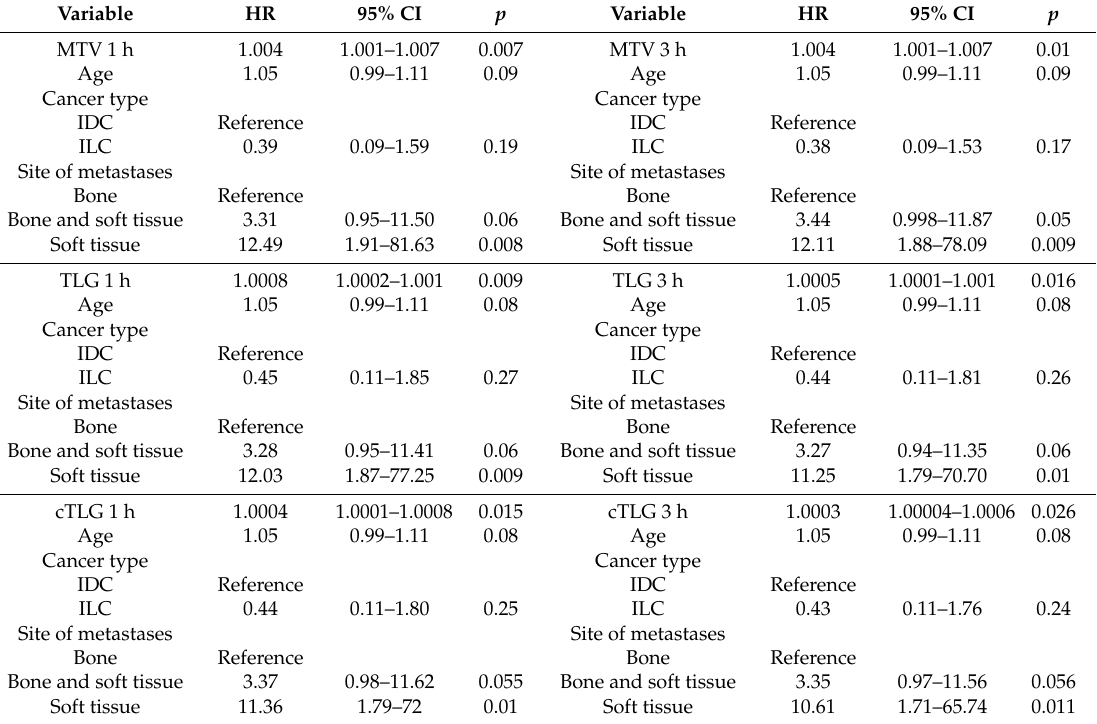
Table 3. Multiple Cox regression analyses of the PET measures on baseline